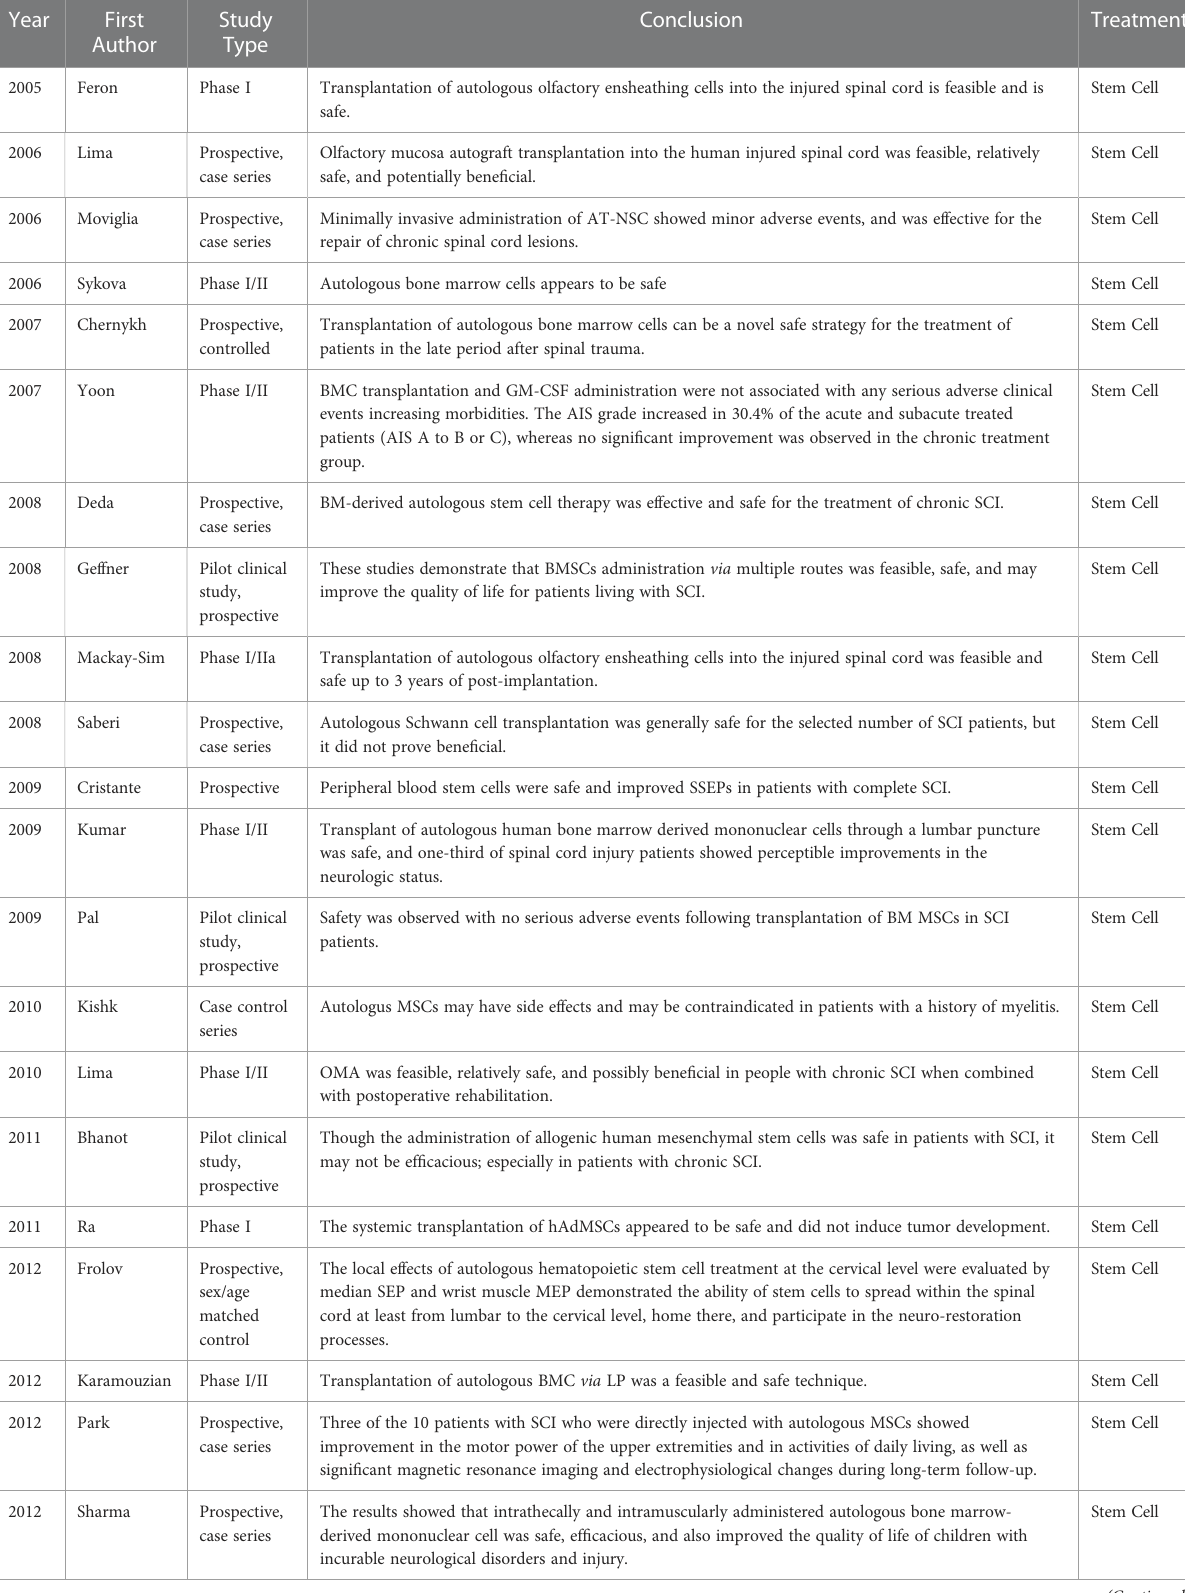
TABLE 2 Stem cells clinical studies summary